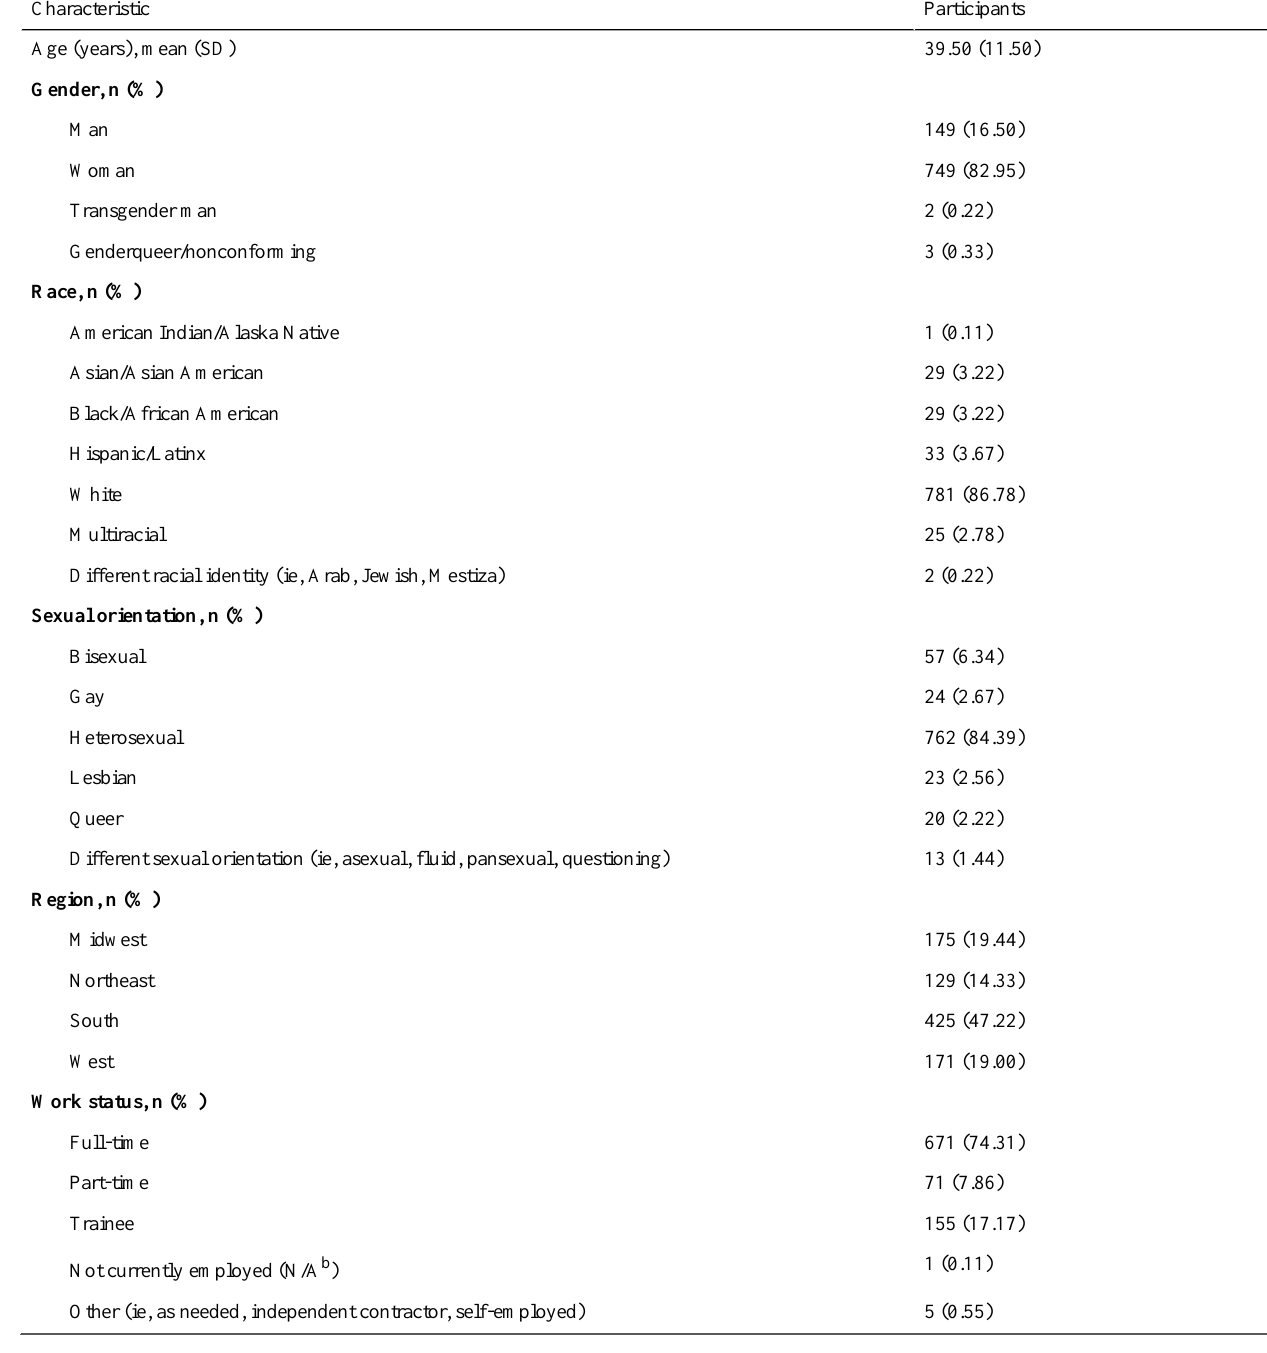
Table 1. Demographic characteristics of the full sample (N=903). a